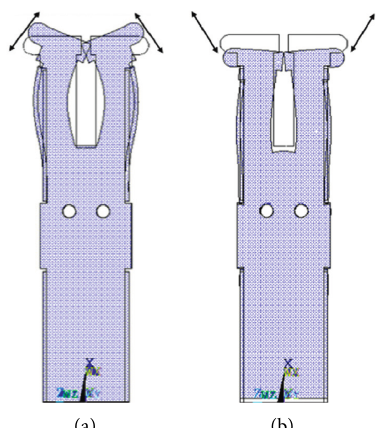
Figure 2: Operating mode of the stator. (a) Partial second-order bending vibration. (b) Global first-order longitudinal